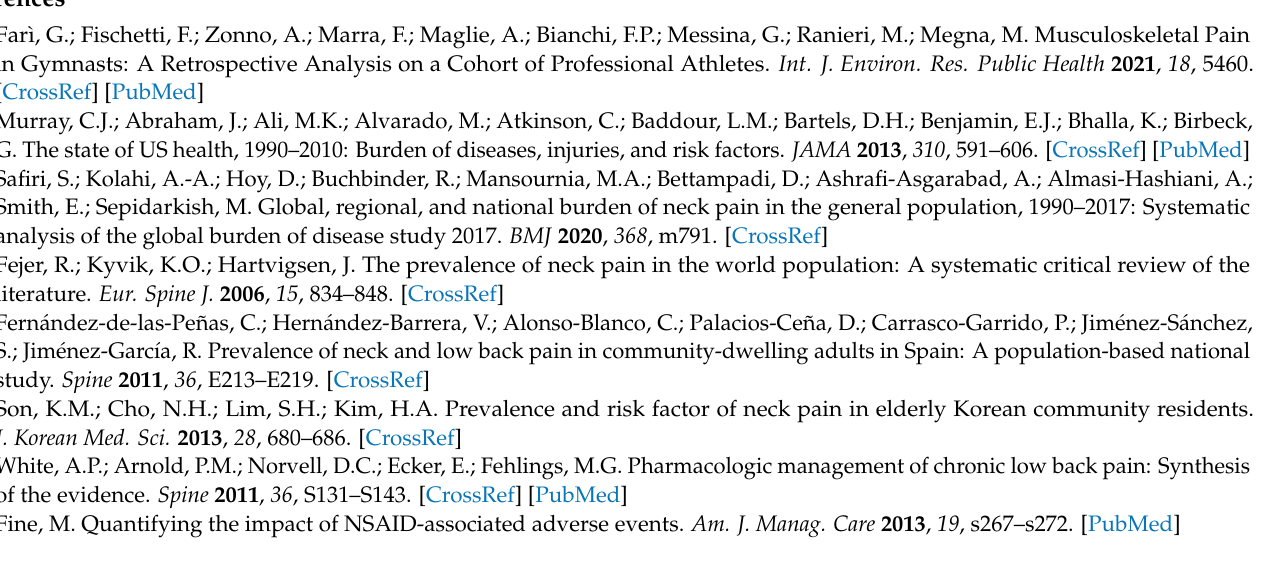
Table S4: Analysis of between-group differences with the linear mixed model, Table S5: Summary of treatment-related adverse